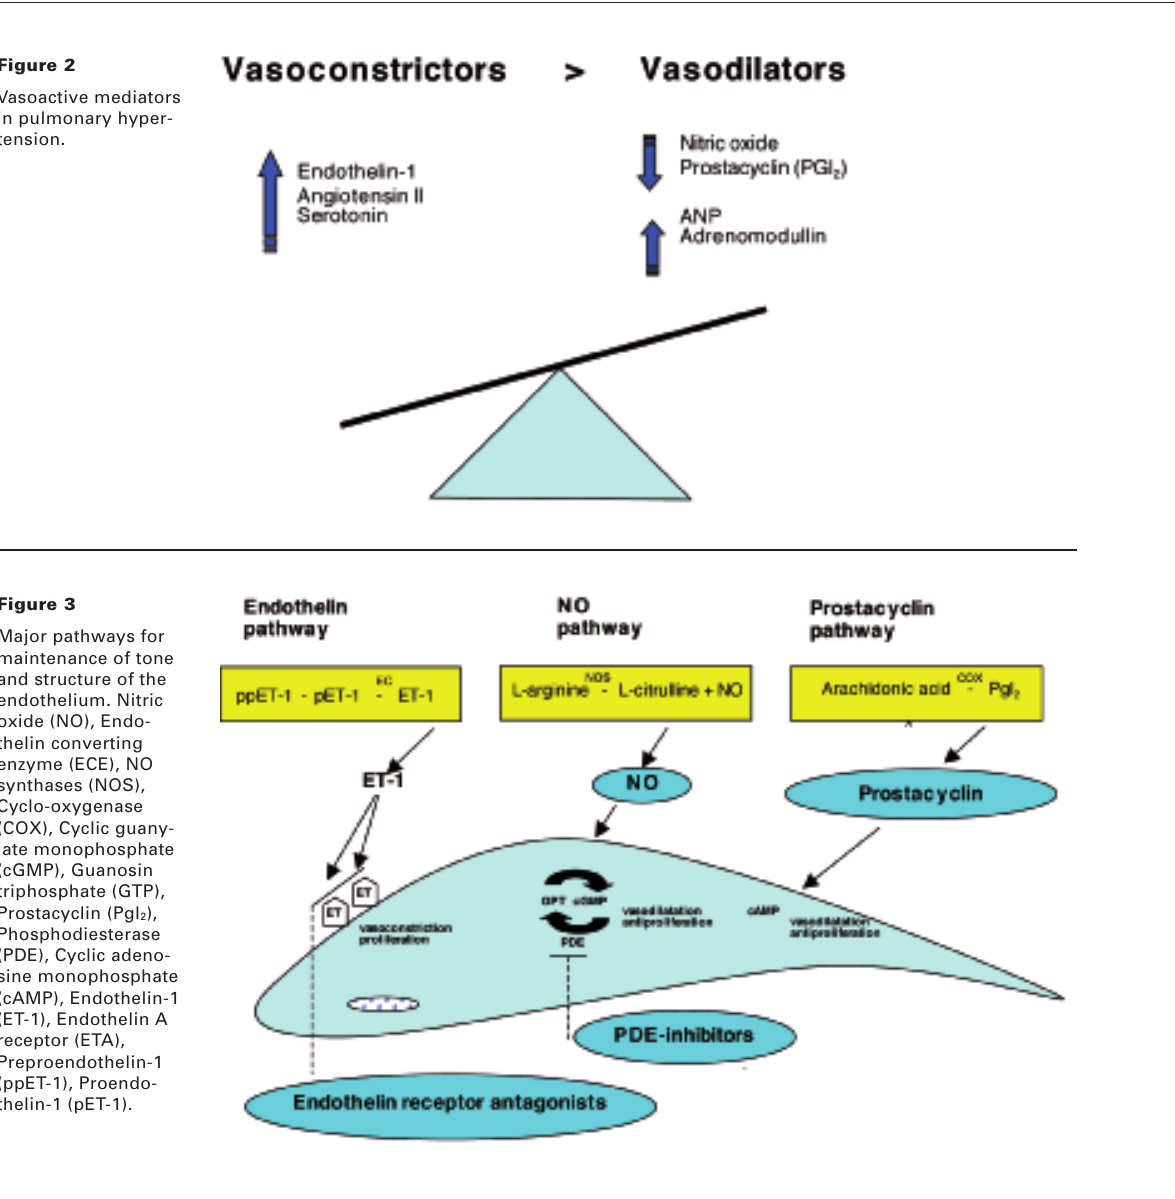
Figure 2 Vasoactive mediators in pulmonary hyper- tension.